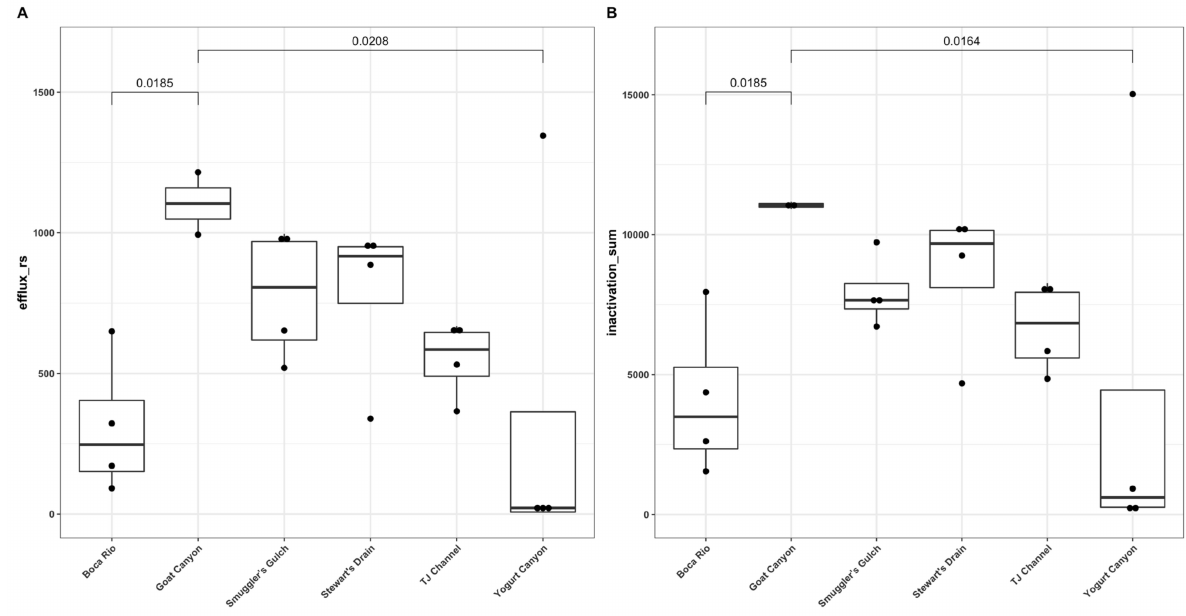
Figure 5. Sum of efflux ( A ) and inactivation ( B ) genes found in water samples, by